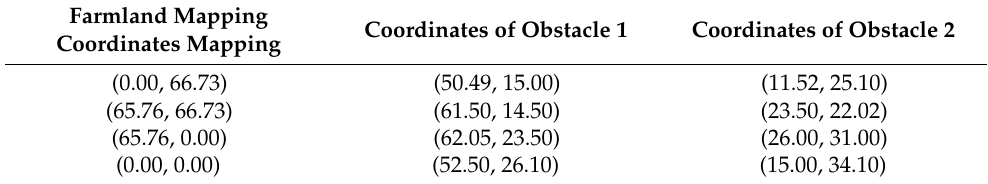
Table 7. Coordinate mapping to Figure 11b. Farmland